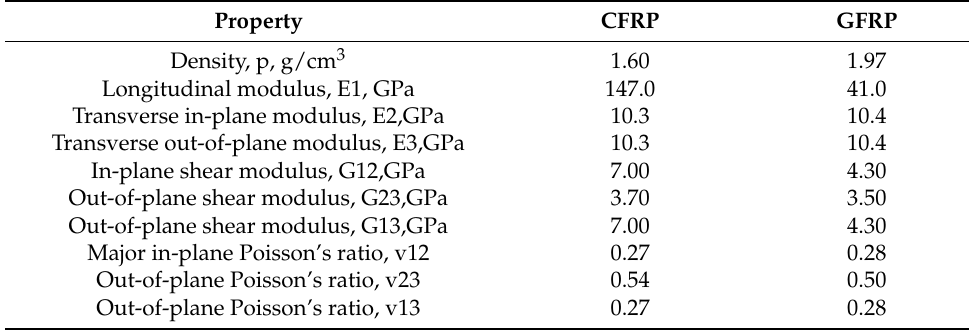
Table A2. Properties for the CFRP and GFRP lamina, values adopted from